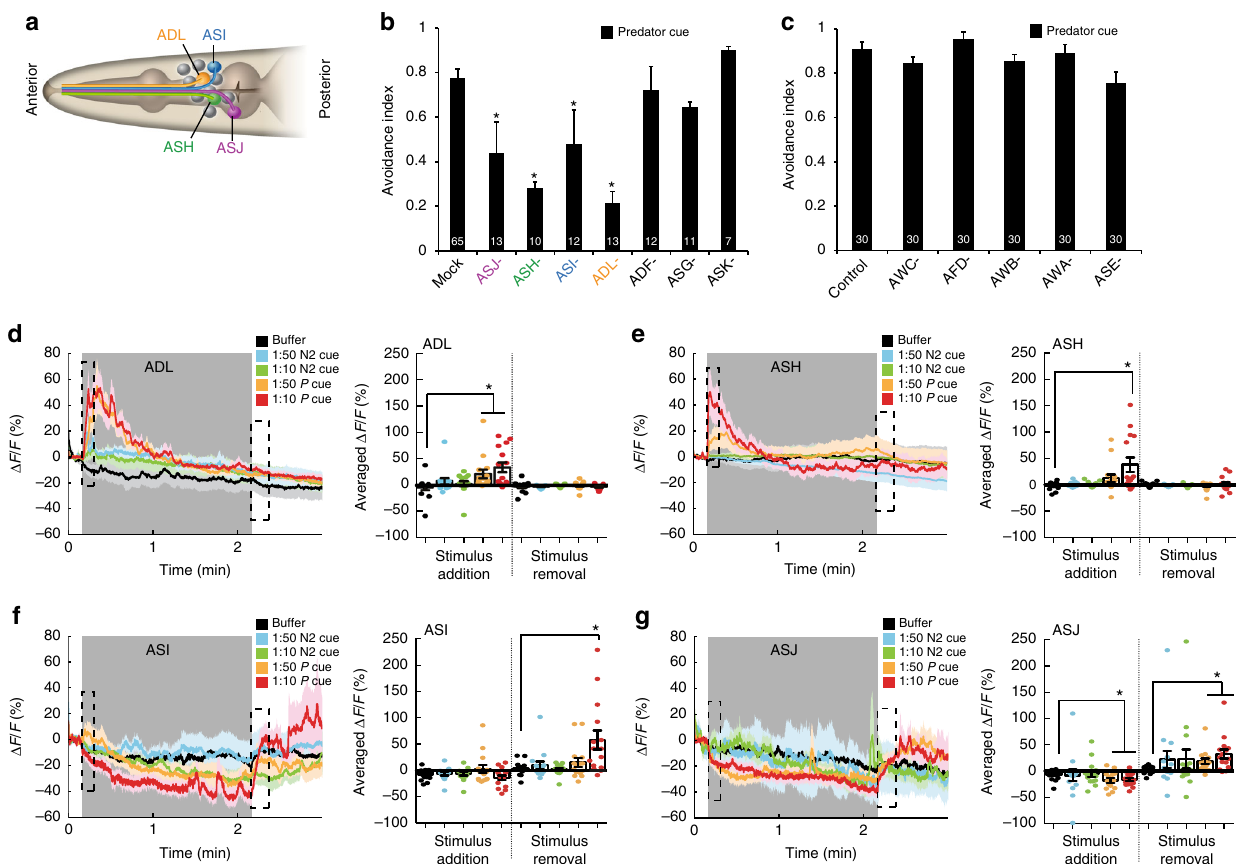
Fig. 2 Multiple sensory neurons are required for avoidance of predator cue. a Schematic showing amphid sensory neurons with key neurons highlighted. b Cell and ( c ) genetic ablations showing that ASJ, ASH, ASI, and ADL sensory neurons, but not other amphid neurons, are required for avoidance of predator cue. Averages, s.e.m. and numbers of animals tested are shown on each bar. d – g Average calcium responses of transgenic animals ( n > 13 for each condition) expressing the GCaMP family of indicators in d ADL, e ASH, f ASI, or g ASJ sensory neurons to predator cue ( P cue) or C. elegans secretions (N2 cue). Each experiment was a 180 s recording where control (M9 buffer), C. elegans secretions (N2 cue), or predator cue ( P cue) in different dilutions was added at 10 s and removed at 130 s (stimulus is indicated by a shaded gray box). Bar graphs, average percentage change during the 10 s after stimulus addition (dashed box), or 15 s after stimulus removal (dashed box) are shown. Error bars and shaded regions around the curves represent s.e.m. *p <